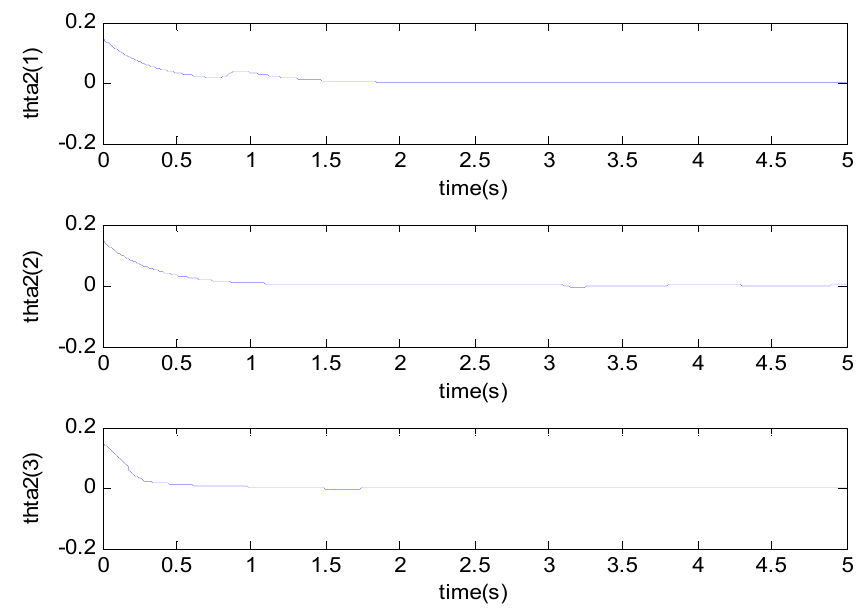
Figure 8. The second parameter using the ABFSMC approach.